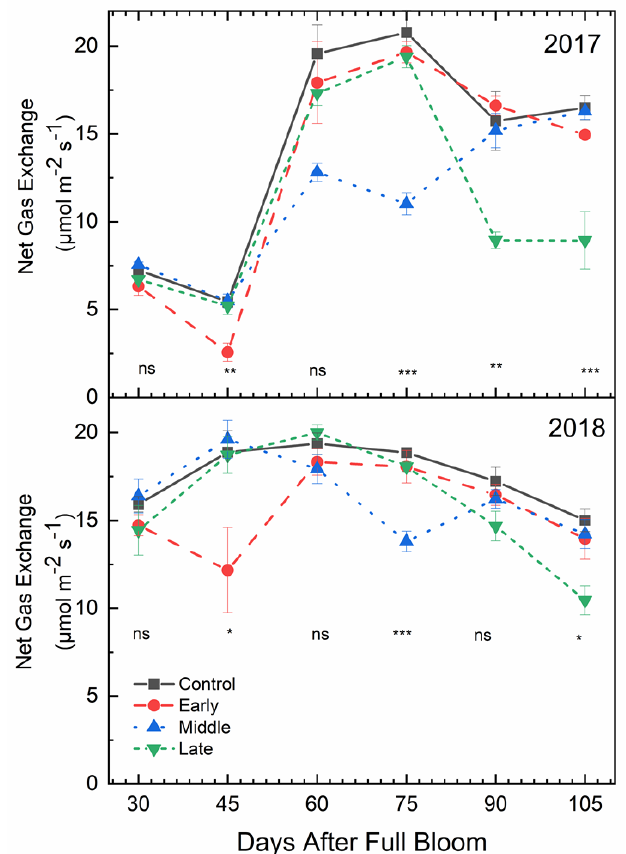
Figure 4. Mean mid- morning net gas exchange (μmol CO 2 m − 2 s − 1 ) (±SE; n = 3) of ‘Honeycrisp’